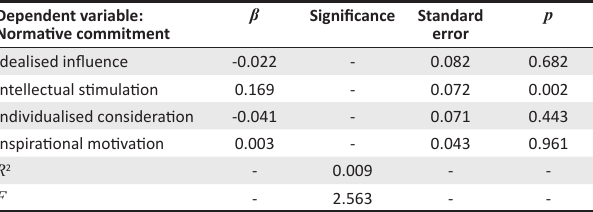
TABLE 6: Transformational leadership style constructs as predictors of normative commitment. Dependent variable: Normative